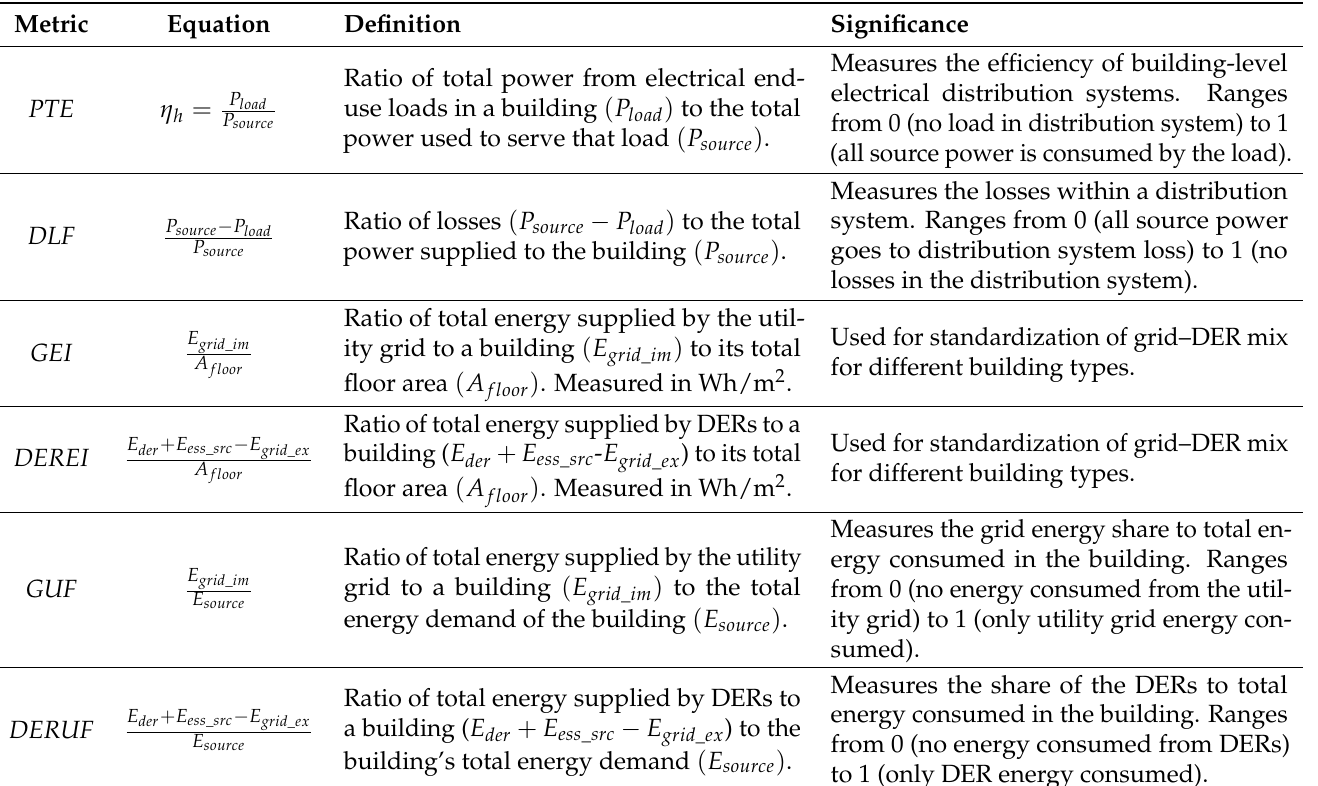
Table 1. Summary of proposed